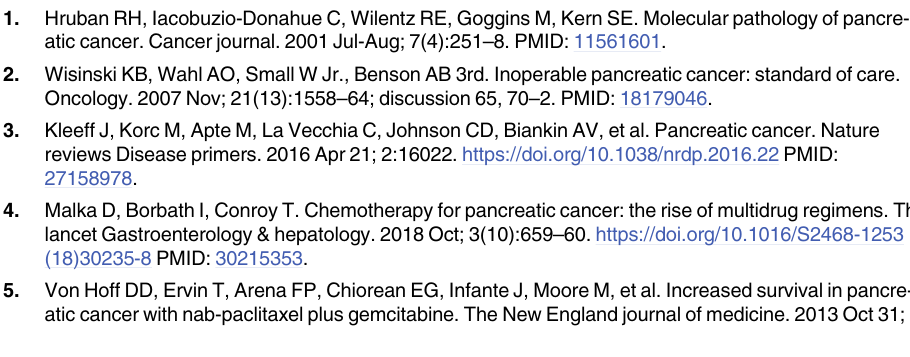
S4 Fig. Autoradiography of [ 14 C]-5-FU (A) and of [ 18 F]-FAC (B) in four organoid tumor sec- tions. Pimonidazole and H&E staining of that tumor section (C and D). Scale bar = 5 mm. S5 Fig. Autoradiography of [ 3 H]-Capecitabine (A) and of [ 18 F]-FAC (B) in three organoid tumor sections. Pimonidazole and H&E staining of that tumor section (C and D). One [ 18 F]- FAC autoradiography image is missing (middle tumor) due to an injection problem. Scale bar = 5